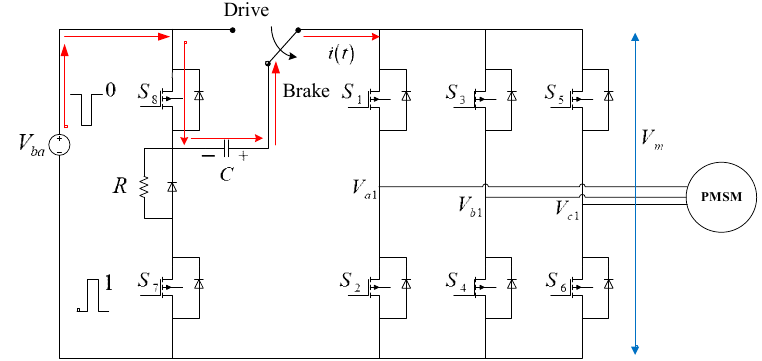
Figure 5. Current loop when the battery in series with the capacitor.